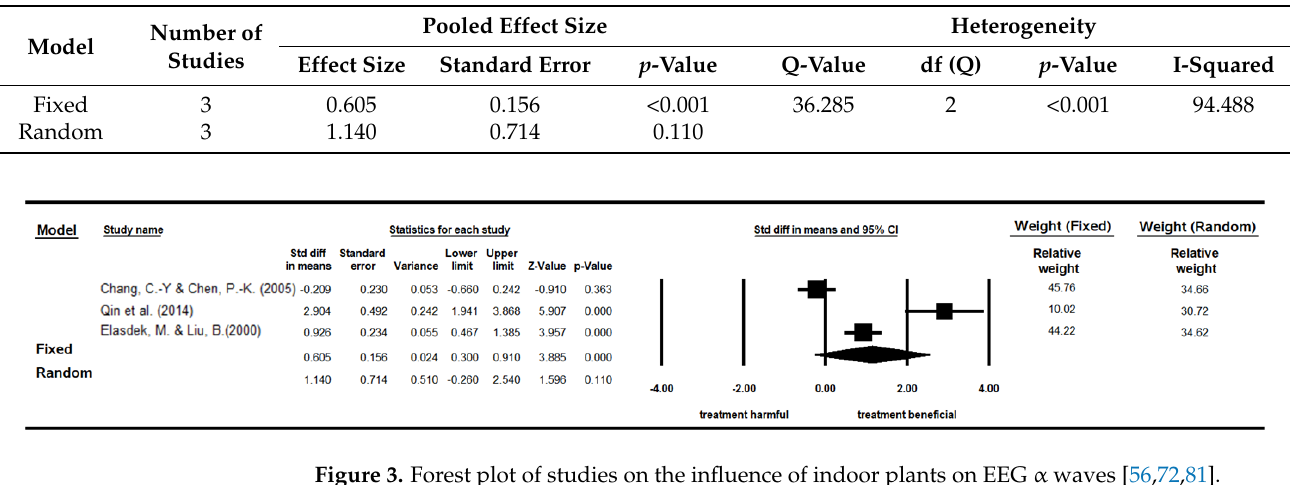
Table 12. Original data of the studies examining the influence of indoor plants on EEG β waves.